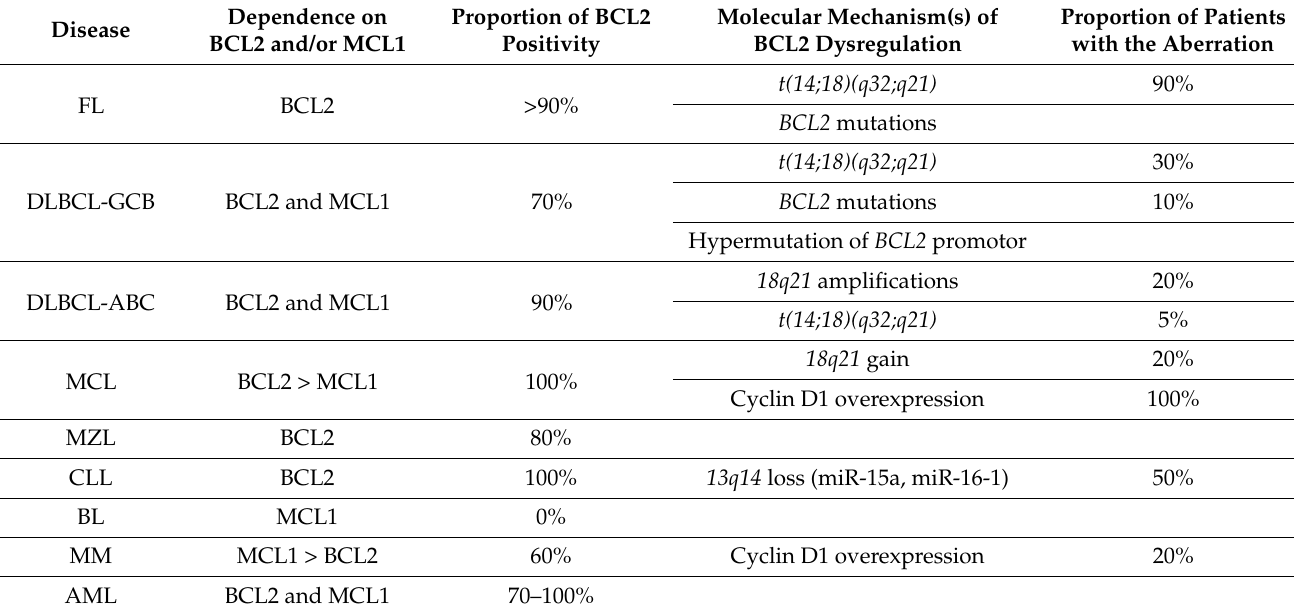
Table 2. BCL2 expression and mechanisms of BCL2 deregulation in hematologic malignancies.